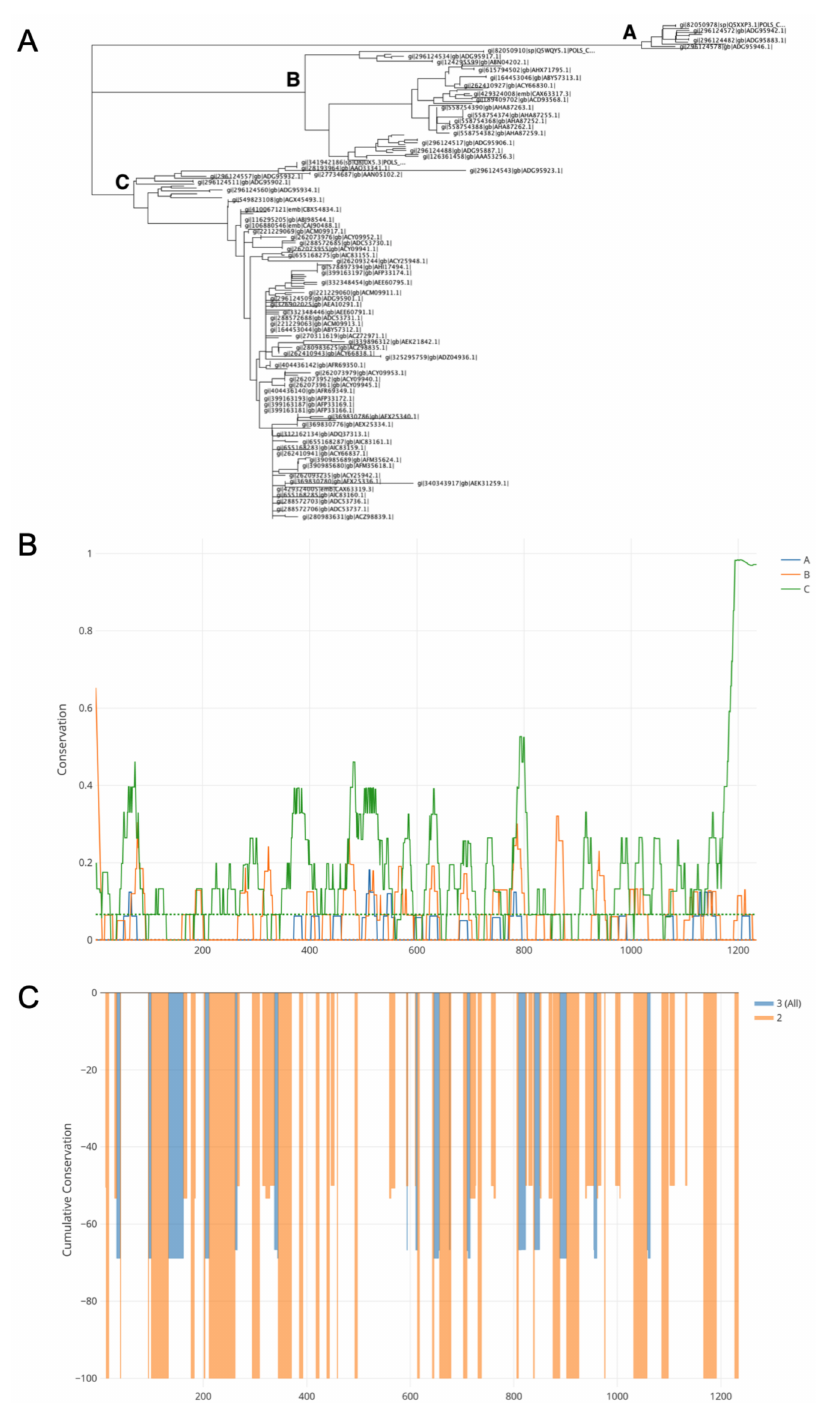
Figure 1. Design of mosaic chikungunya virus (CHIKV) structural polyprotein sequence. ( A ) Neighbour-joining tree of full-length CHIKV structural proteins. ( B ) Intra-clade conservation ( A – C ) assessed by in-house sliding window algorithm. Conservation scaled between 0 and 1 with 0 being fully conserved within respective clades. Q1 cut-off for conservation of each clade indicated by coloured dashed line. ( C ) Inter-clade conservation (between A, B and C) across the three clades. Degree of conservation between either all three clades (blue) and only two clades (orange) indicated by cumulative conservation between 0 to −